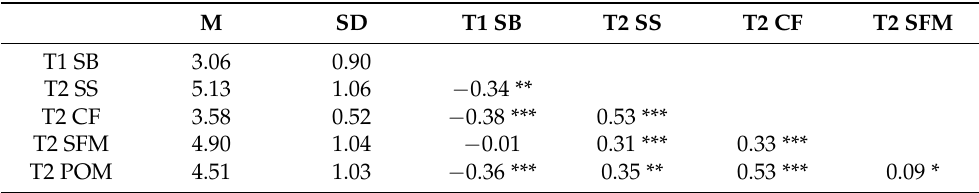
Table 1. Descriptive statistics and correlation